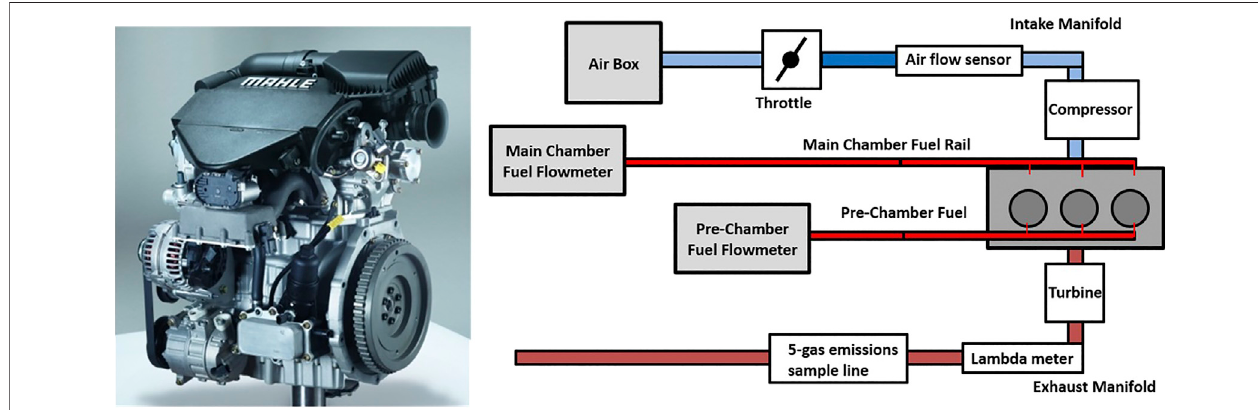
FIGURE 3 | DI3 engine (left) and schematic of the testing setup (right)